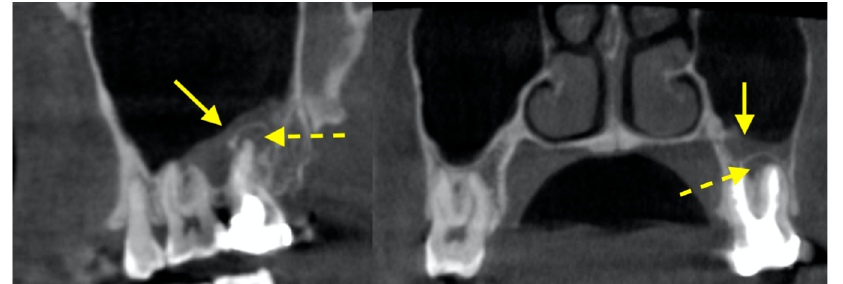
Figure 4. Sinus membrane thickening (solid arrow) in the left maxillary sinus associated with a periapical lesion (dotted arrow).